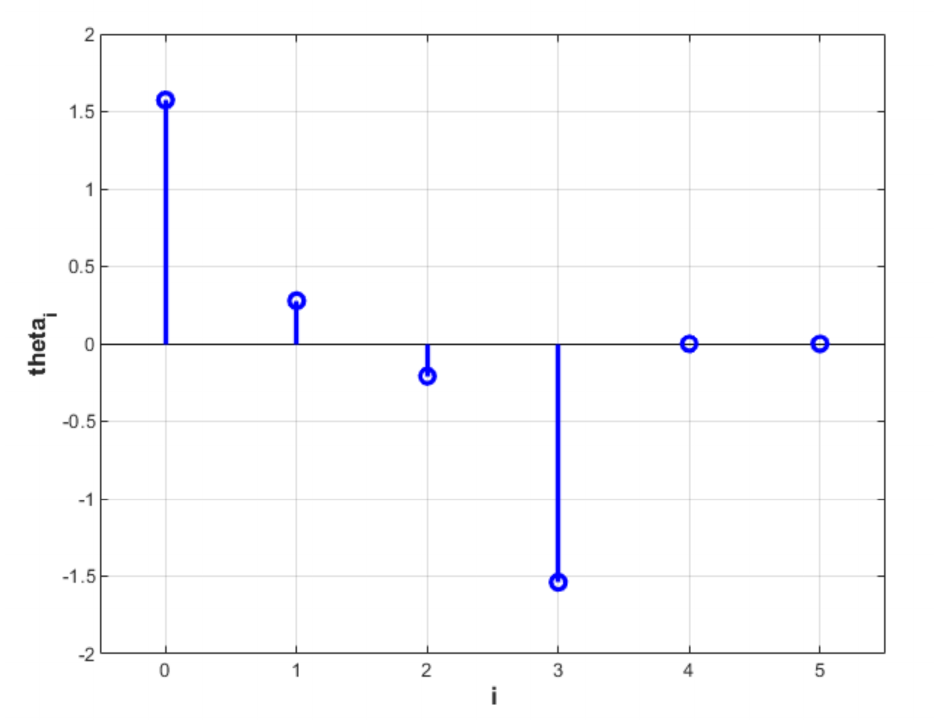
Figure 6. Controller parameters for (cid:101) ω = 2.5 [ rad/d ] and m =